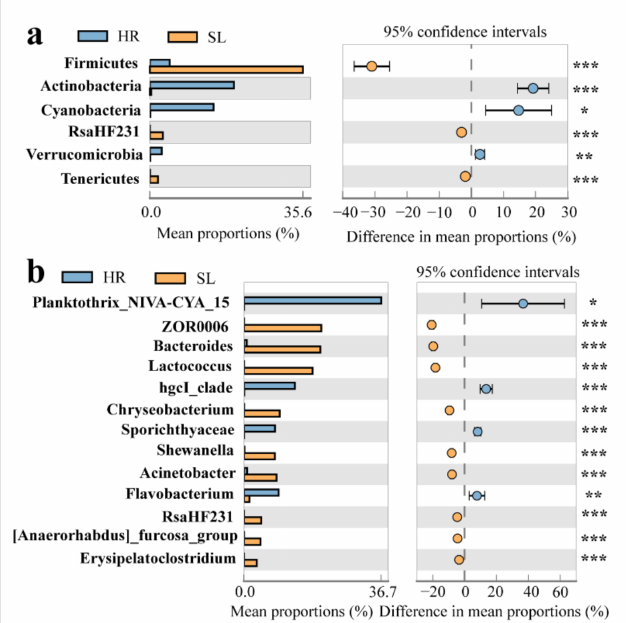
Figure 4. Significantly different bacterial community compositions among the subsidence lake and its connected river. ( a ) phylum level; ( b ) genus level; SL: subsidence lake; GM: coal gangue mountain waters; HR: Huihe River; * p < 0.05, ** p < 0.01, *** p <